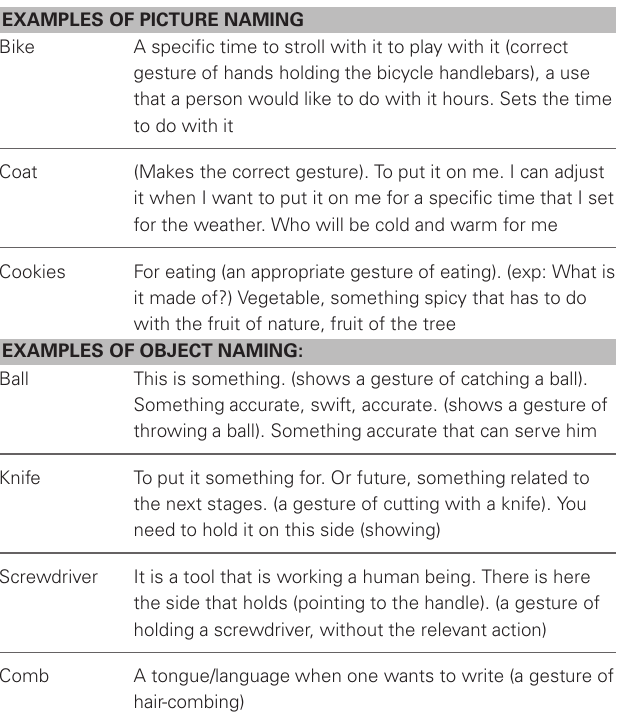
Table 1 | Examples of Nissim’s picture and object